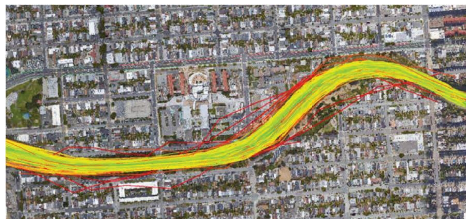
Figure 4: Visualization of the standard deviation of the distance between trajectory points and the road